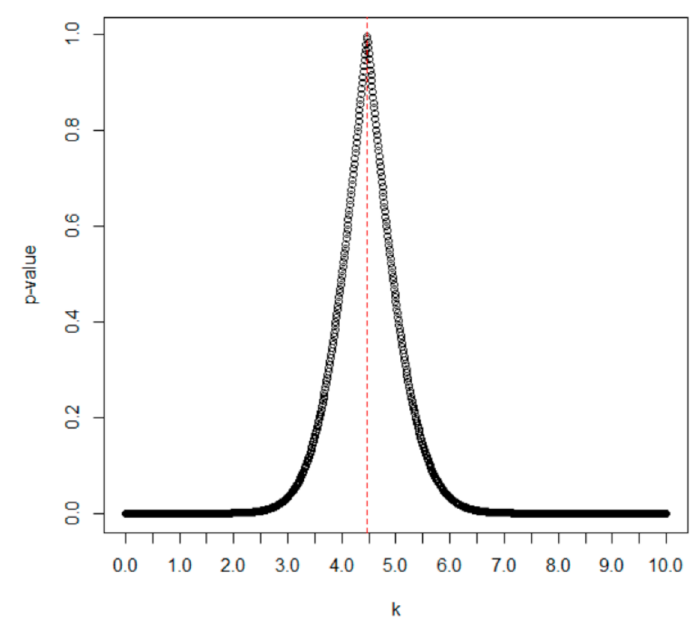
Figure 7. The p -values for Gini test versus k